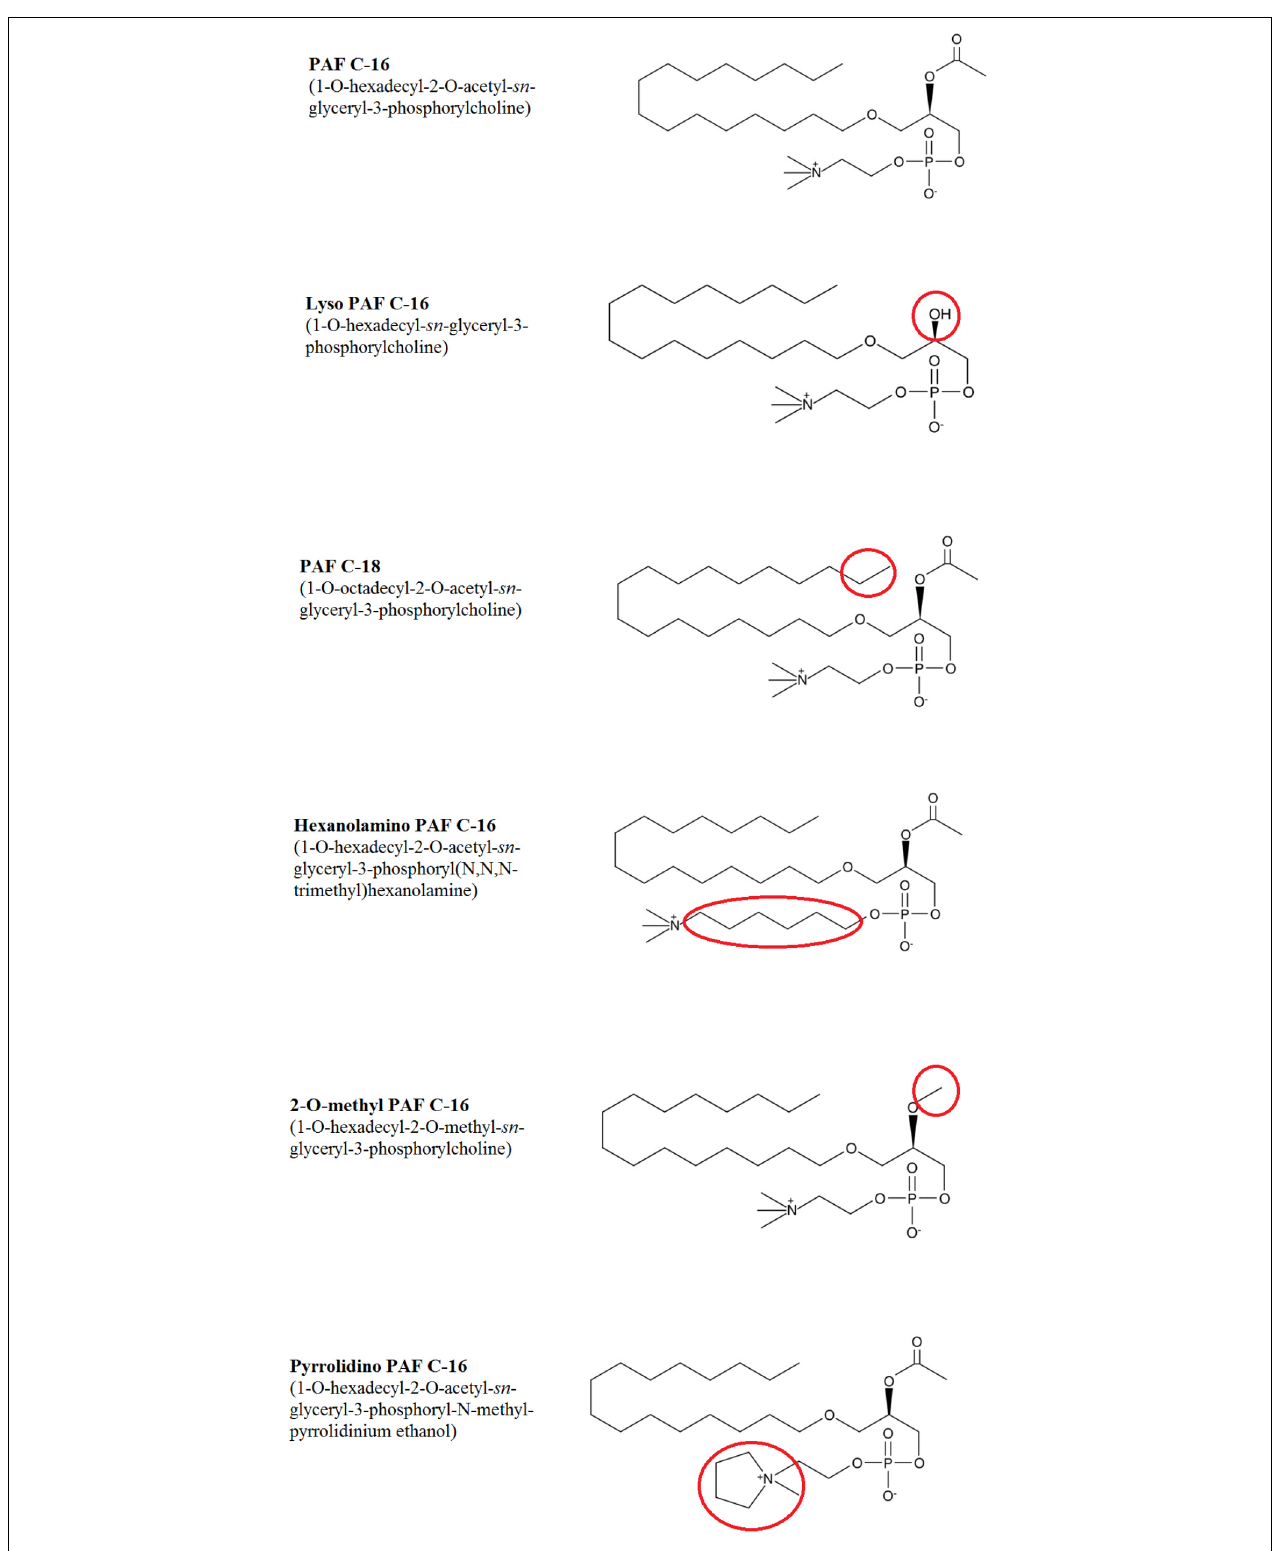
FIGURE 3 | Chemical structures of PAF C-16 and its structural analogs. Each analog has a small modification in the structure as compared to naturally occurring PAF C-16 which is highlighted in the red circles.